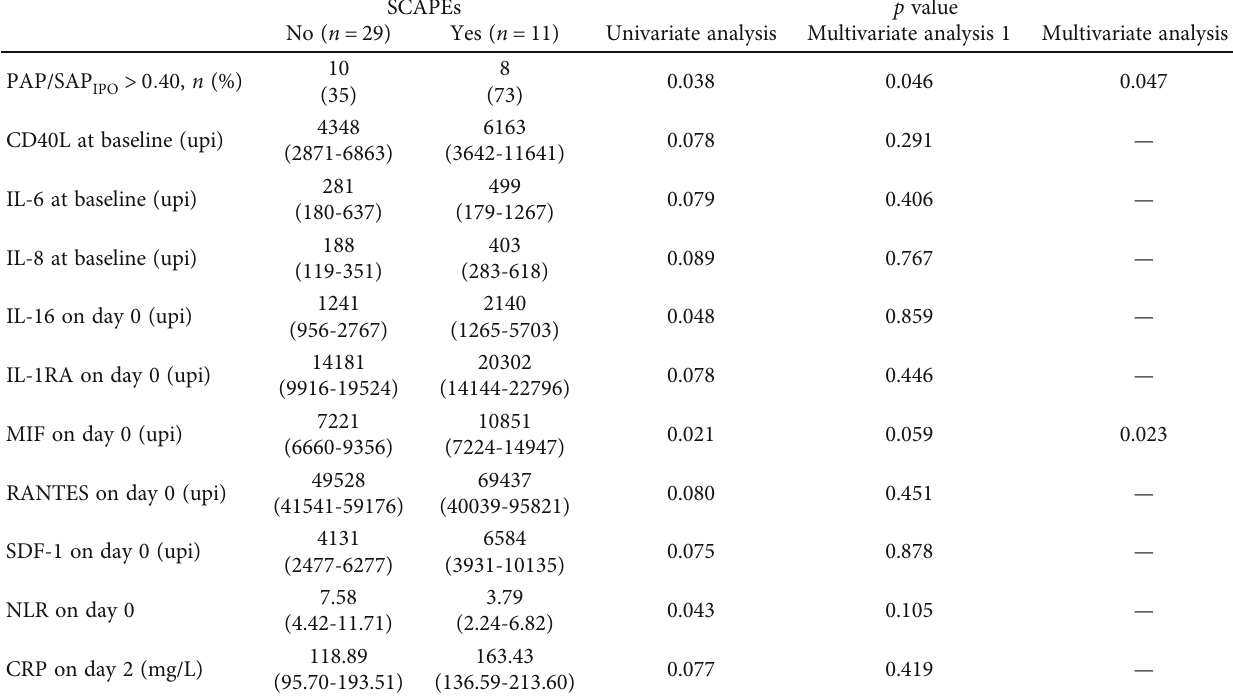
Table 6: Variables associated with signi fi cant postoperative cardiopulmonary events (SCAPEs).